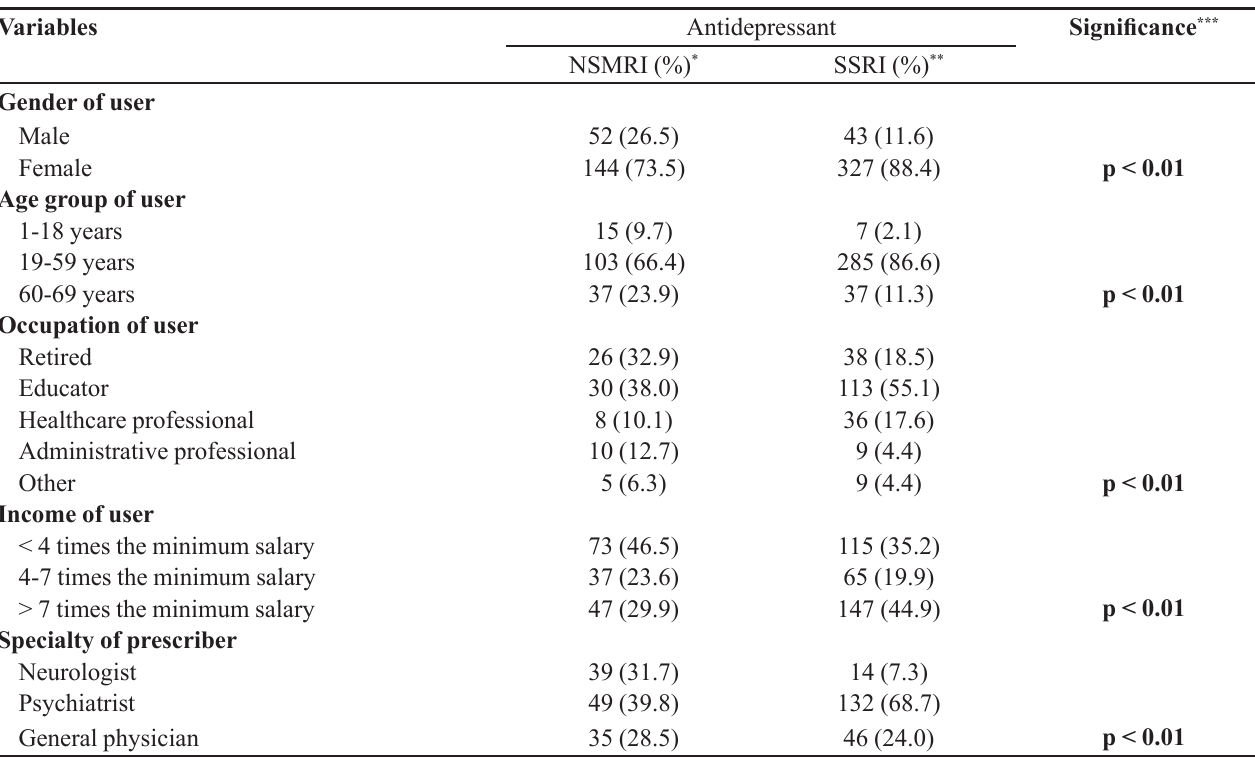
TABLE III - Subgroup of antidepressants prescribed according to selected characteristics. Pharmacy of the Civil Servants’ Clinic (CLISERV) of the Municipal Government of Belo Horizonte, Minas Gerais, Brazil, 2005